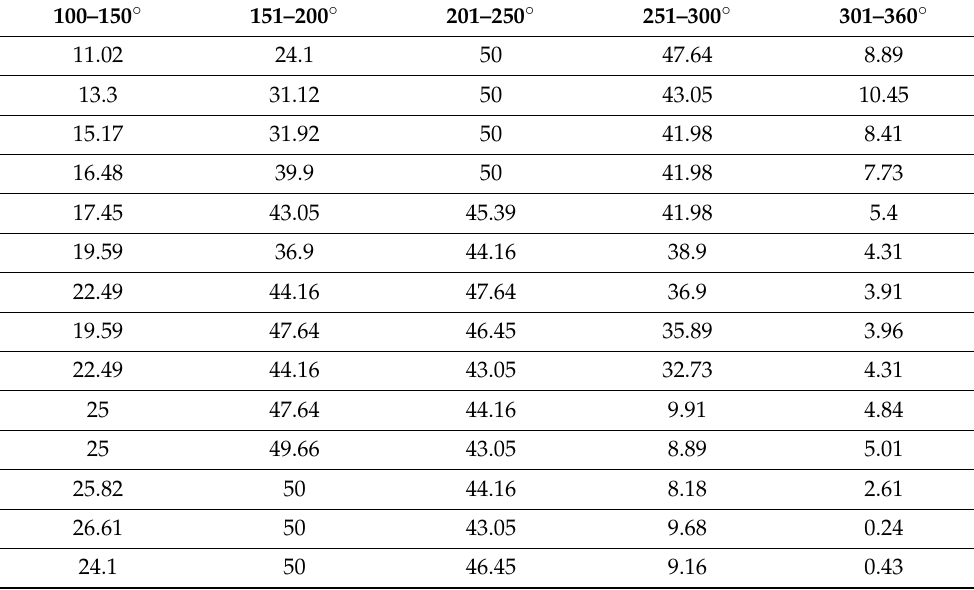
Table 5. Data Sensed in a Mobile Environment for the Patch Antenna.